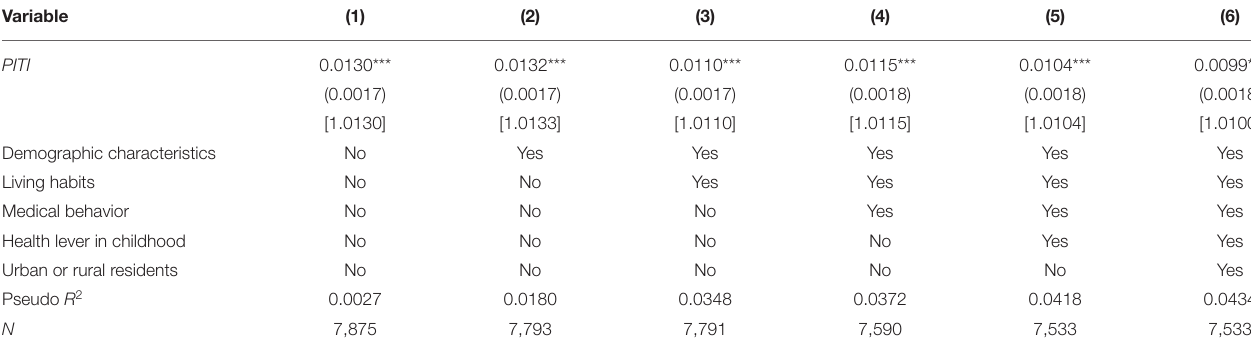
TABLE 7 | Stepwise regression for self_HL .